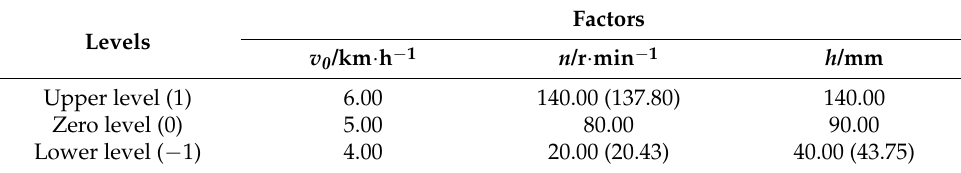
Table 2. Horizontal coding table of experimental factors.